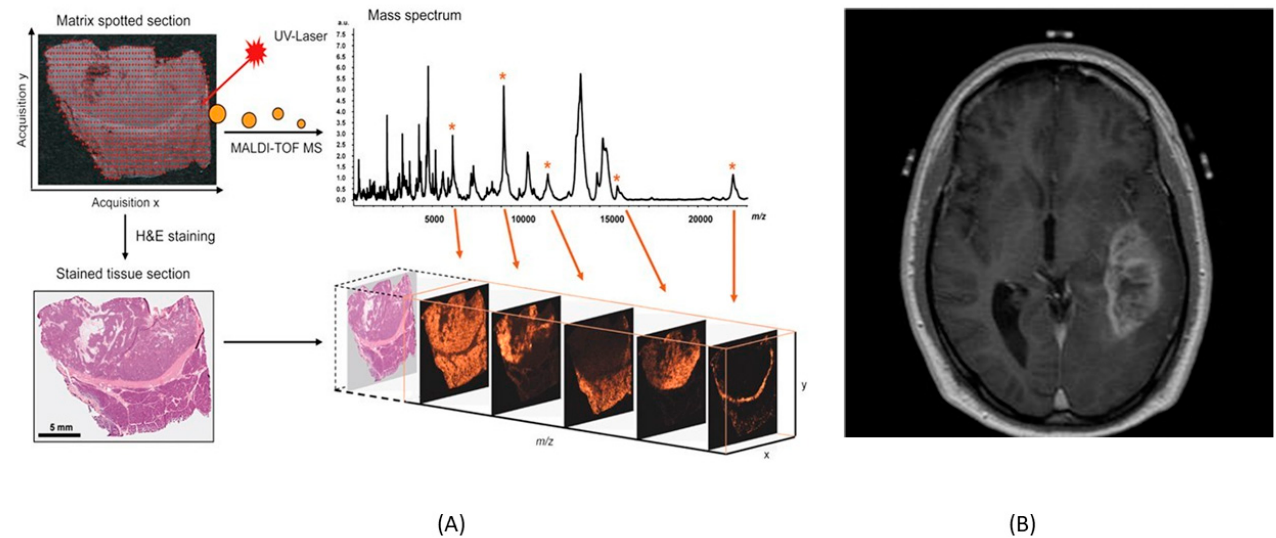
Figure 2. ( A ) MALDI-IMS generating mass spectrum and stained tissue selection with the patches. ( B ) MRI image of brain to detect the diseases using a power full magnetic field and pulse of radiofrequency. ( A ) is reprinted with permission from reference [21], 2015, Springer Nature. ( B ) is reprinted with permission from reference [22], 2020, AIP Publishing.